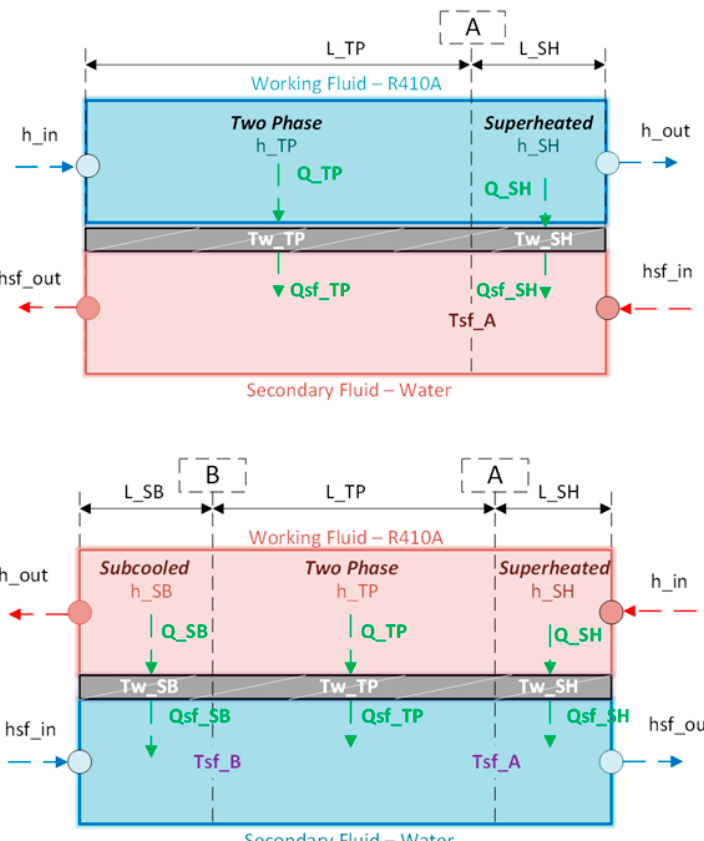
Figure 5. CV formulation for the evaporator (up) and the condenser (bottom) heat exchanger models.